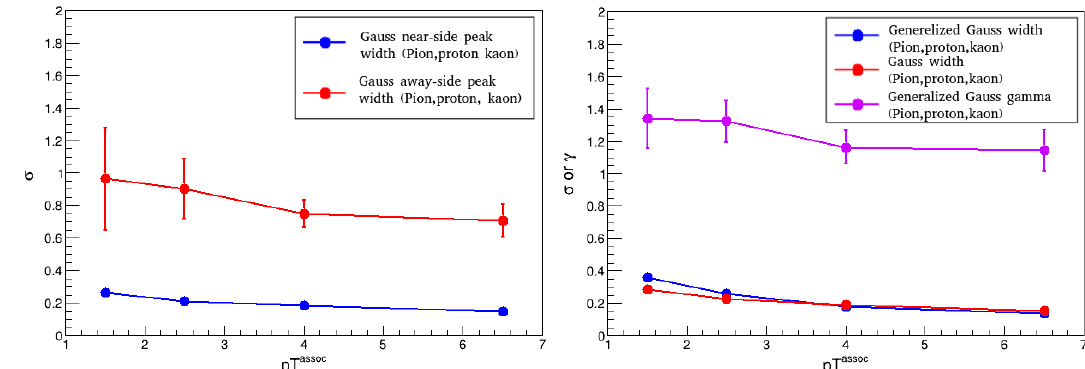
Figure 2. The peak width for Gaussian fitting (on the left side) and for generalized Gaussian fitting (on the right side) for 5 < p trigger < 8 GeV/ c and different p assoc values. T T